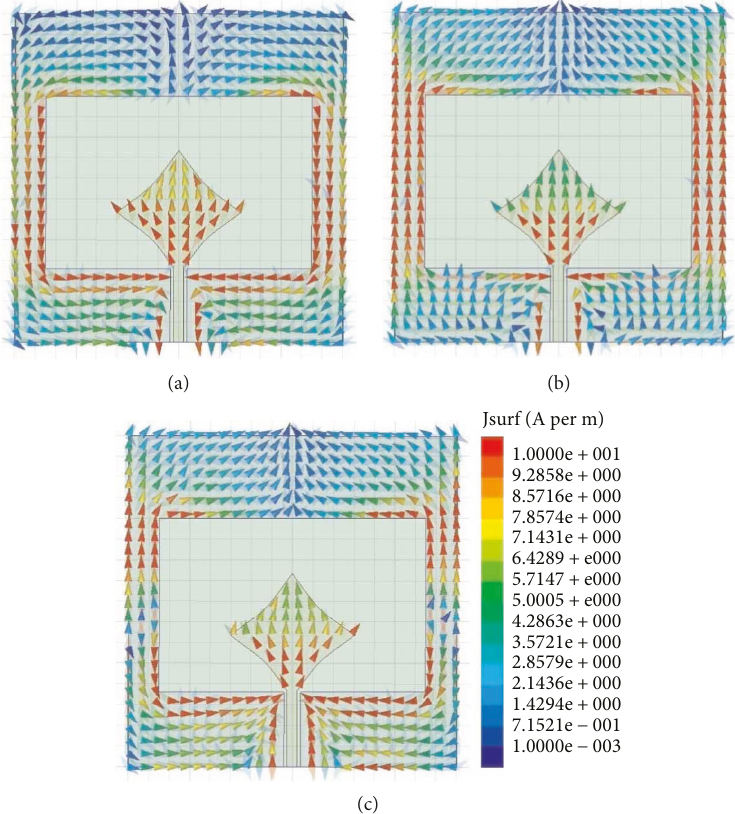
Figure 8: Simulated current distributions at (a) 2.8GHz, (b) 3.6GHz, and (c) 7.1GHz.